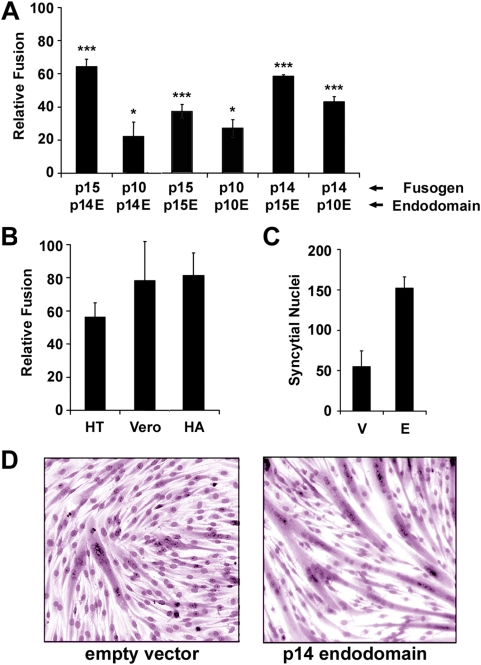
The FAST protein endodomains function as general enhancers of syncytium formation.(A) QM5 cells were co-transfected with plasmids expressing the indicated FAST proteins (NBV p10, p14, or p15) and the indicated endodomain (from p10 (p10E), p14 (p14E) or p15 (p15E)). The extent of cell–cell fusion was quantified as described in Figure 1A, and results are presented as the relative fusion level±S.E. (n = 4), setting the cells co-transfected with the full-length fusogen as 100% fusion enhancement and those co-transfected with empty vector as 0% fusion enhancement. Syncytia were quantified during the linear range of the fusion assay (12 h post-transfection for p10; 8 h post-transfection for p14 and p15). Statistically significant increases in syncytium formation relative to cells co-transfected with fusogen plus empty vector are indicated with asterisks (*p<0.05; ***p<0.001). (B) HT-1080 (HT) or Vero cells were co-transfected with plasmids expressing p14 and the p14 endodomain, or QM5 cells were co-transfected with the p14 endodomain and influenza virus hemagglutinin (HA). The relative fusion level±S.E. (n = 4) was determined as described in (A). (C) C2C12 murine myoblasts were transfected with the p14 endodomain expression plasmid or empty vector and induced to undergo differentiation-dependent cell–cell fusion. The extent of syncytium formation at 72 h post-transfection was quantified using a syncytial index, as described in Figure 1A, and results are reported as the average number of syncytial nuclei per field±S.E. (n = 4). (D) As for (C), with the extent of syncytium formation in C2C12 cells transfected with the p14 endodomain expression plasmid or empty vector visualized by bright field microscopy of Giemsa-stained monolayers at 72 h post-transfection.